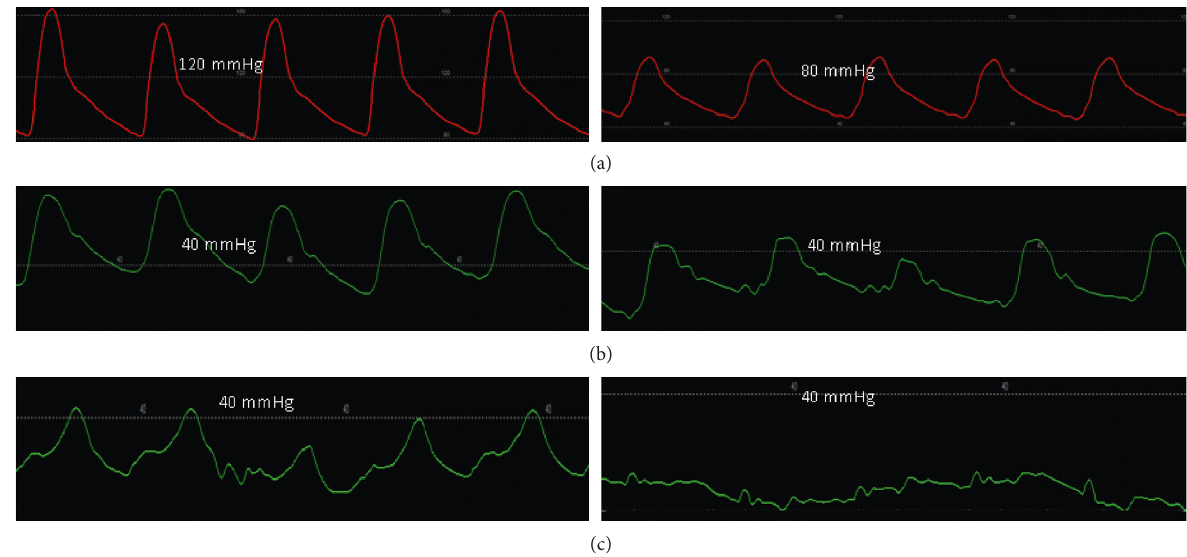
Figure 7: Response of systemic, pulmonary arterial, and pulmonary capillary wedge pressure to nitroprusside. The aortic blood pressure and consequently the LVEDP decreased markedly with introduction of nitroprusside (a). Subsequently, the MPAP (b) and the PCWP (c) demonstrated a marked decrease in pressure